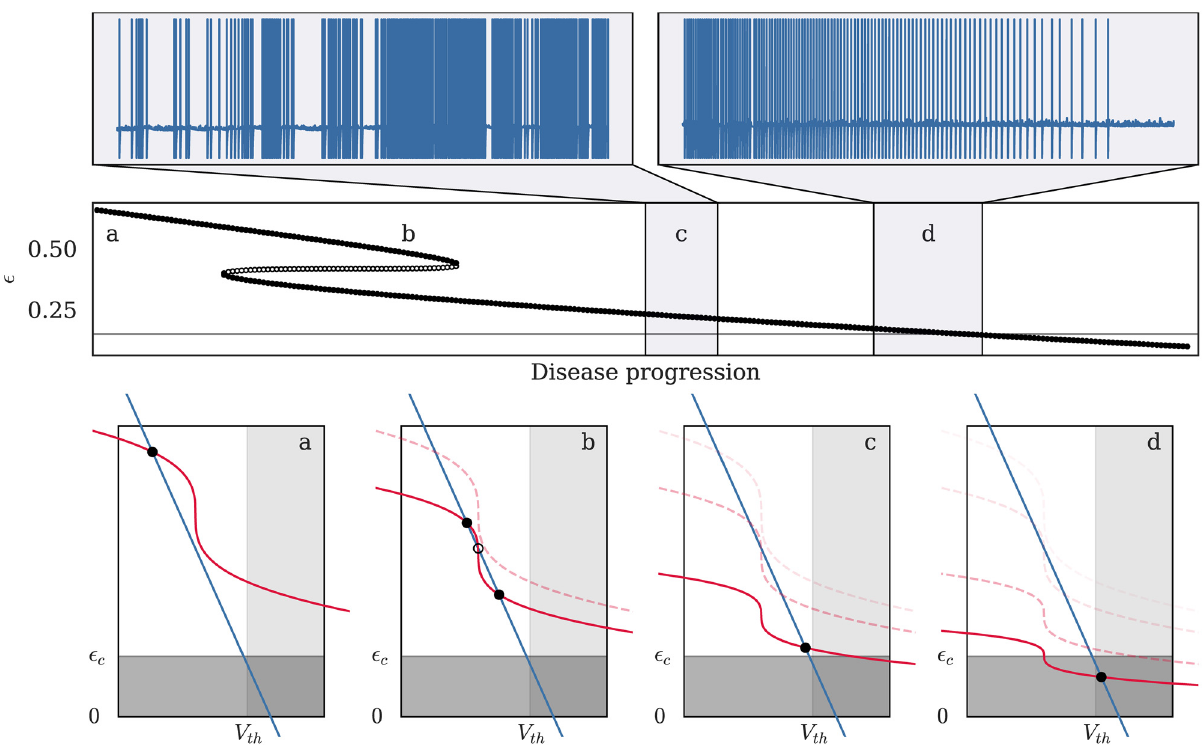
Fig 4. One possible pathway for the transition between healthy and diseased state in the e LIF model. In the model, progressive decrease in the “energetic health” factor α , from 1 to 0.3, leads to a succession of changes in both the number of fixed points (FPs) and in their properties. The middle panel shows the evolution of the FPs’ energy levels—filled circles for stable FPS, empty for unstable FPs—with the grey line marking � the disease progression are also illustrated in phase-space: (a) healthy neuron with a single FP. (b) bifurcation to a 3 FPs state without major changes in the dynamical properties (susceptible but potentially “asymptomatic” cell). (c) bifurcation to a single low-energy FP associated to an extremely excitable state (diseased cell). (d) further decrease of the energetic health brings the FP below the energy threshold � c , leading the neuron to become unresponsive. In stages (a) and (b), the neuron lies in its resting state in the absence of input; however, at stages (c) and (d), the two insets on the upper panel show the membrane dynamics of the neuron for a hypothetical “accelerated evolution” of the disease, where the neuron respectively enters (35-second simulation) and leaves (45-second simulation) the “hyperactive” region where usually subthreshold inputs (here modeled by a Poisson noise) are sufficient to trigger uncontrolled spiking. See S2 Table for detailed